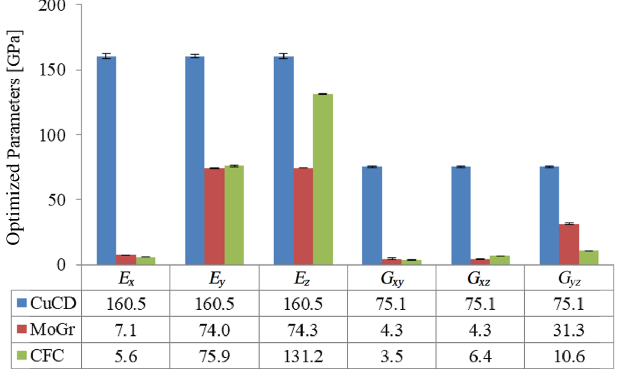
FIG. 23. Optimized elastic and shear moduli.